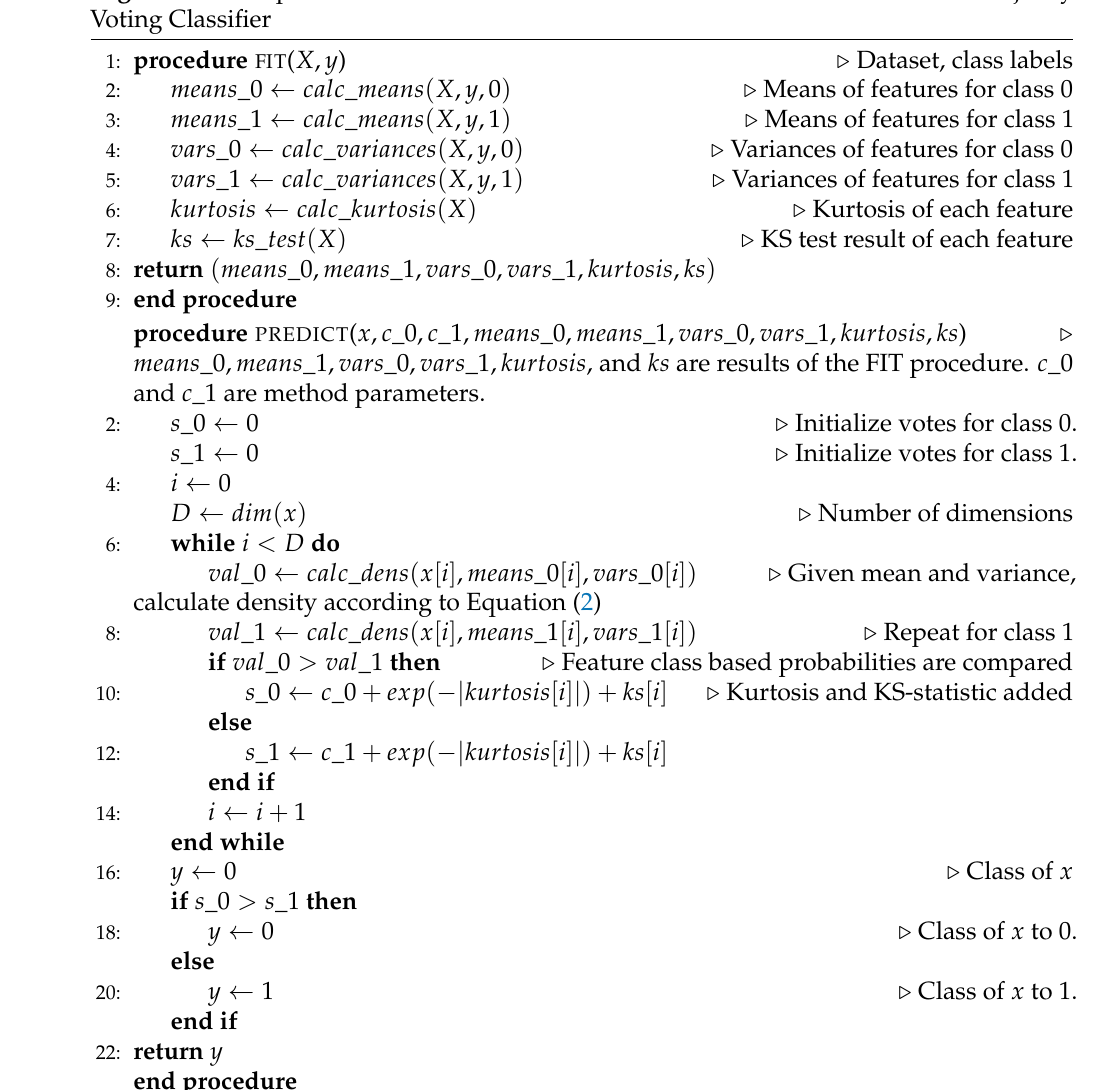
Algorithm 1 Proposed Base Estimator Method I: Gaussian Distribution based